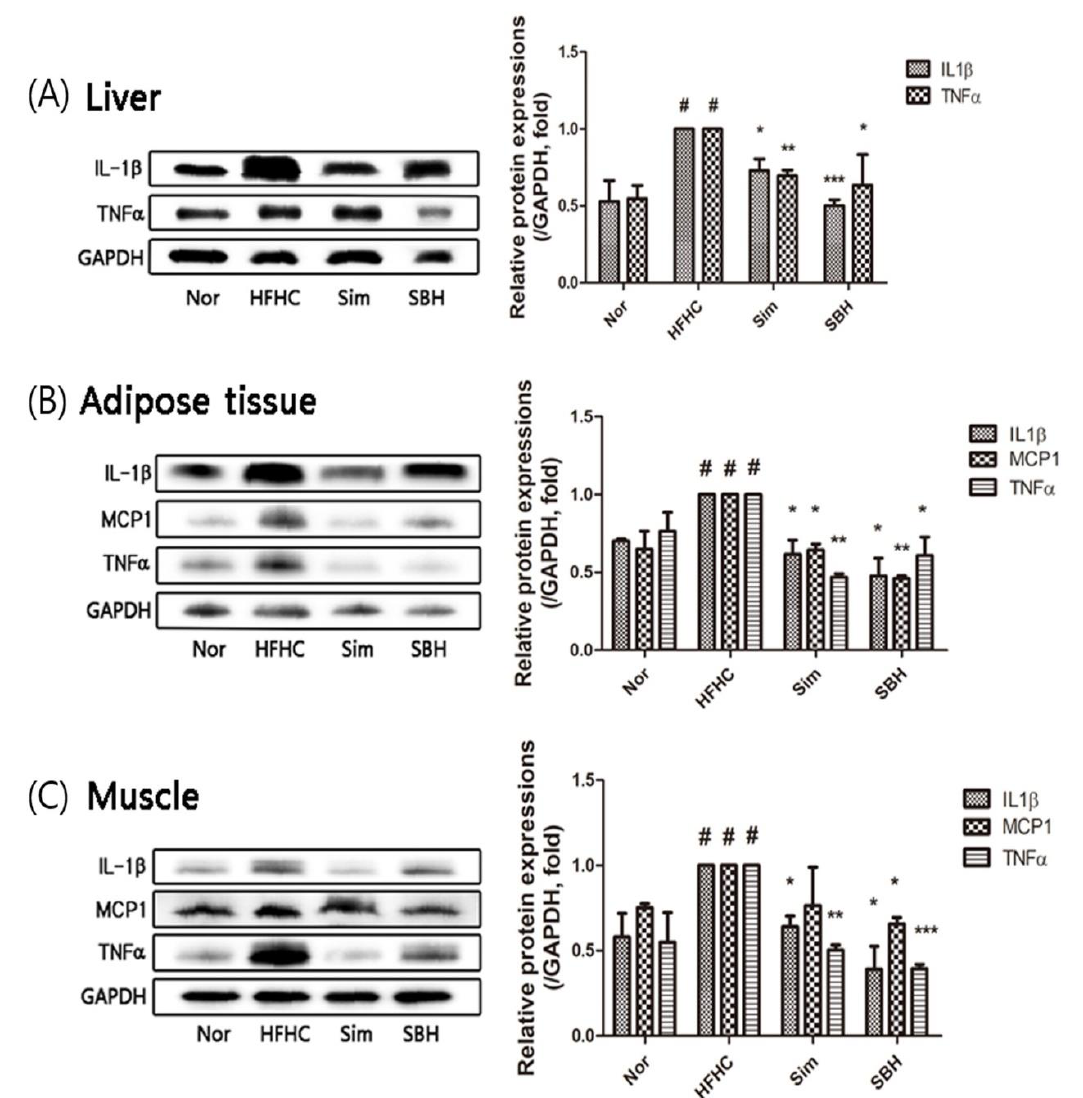
Figure 8. Effects of SBH on the expression of inflammatory cytokines. Western blot analyses of IL-1 β and TNF α in the liver ( A ) and IL-1 β , TNF α , and MCP1 in the adipose ( B ) and muscle ( C ) tissues were performed. Densitometric quantification was expressed as a fold change in the ratio of protein expression/GAPDH (an internal control). The number of experiments: Nor ( n = 3), HFHC ( n = 3), Sim ( n = 3), SBH ( n = 3). Data are expressed as the mean ± SEM. # p < 0.05 compared with Nor; * p < 0.05, ** p < 0.01, *** p < 0.001 compared with HFHC. Nor, normal control group; HFHC, high-fat and